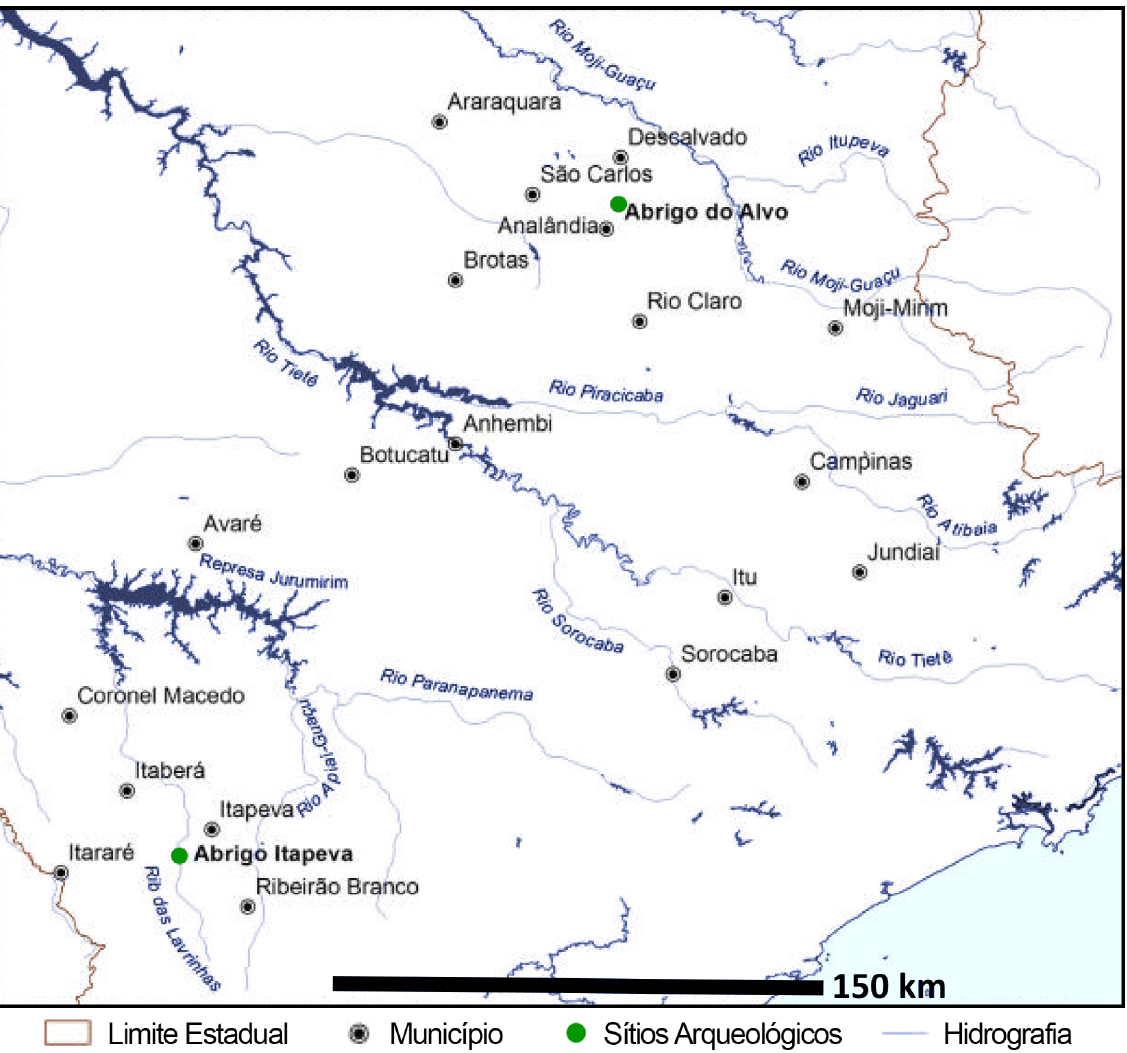
Figura 1: Mapa de localização dos sítios Abrigo de Itapeva e Abrigo do Alvo, São Paulo. Autora: Tatiane Souza. Figure 1. The Abrigo de Itapeva and Abrigo do Alvo sites location map, São Paulo State. Author: Tatiane